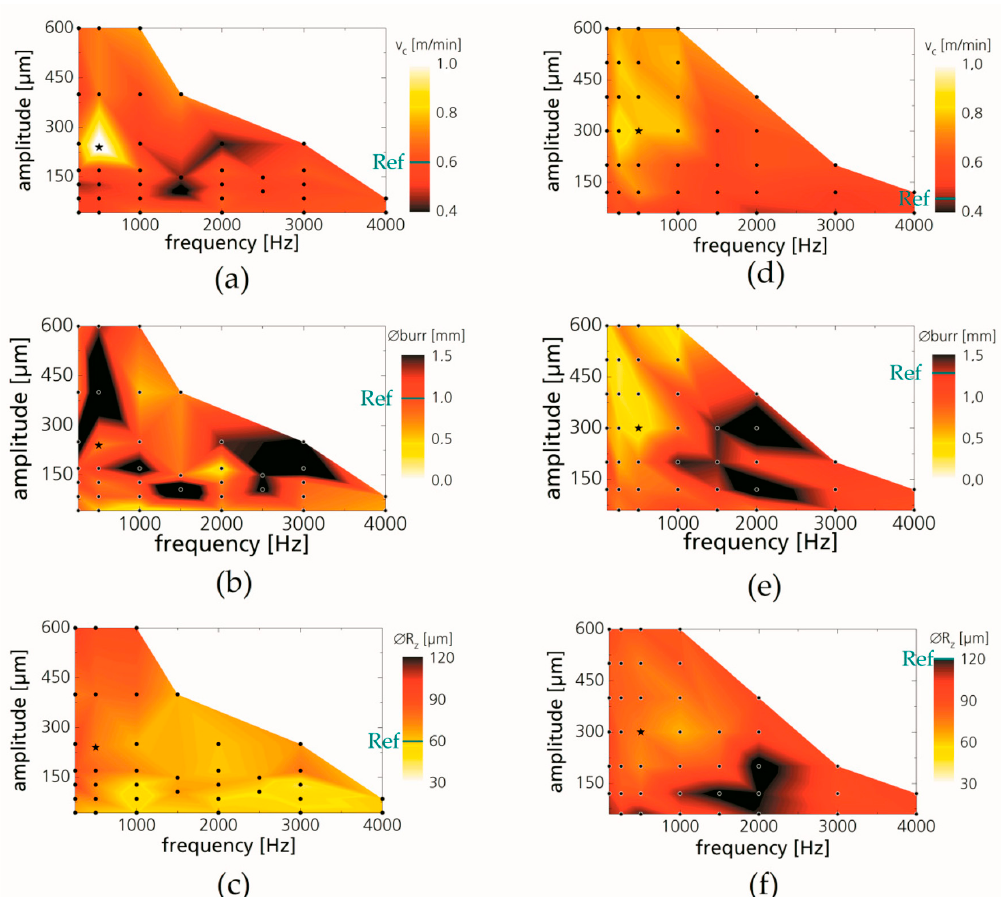
Figure 3. Contour plots of evaluated cutting results for cutting speed ( a , d ), burr height ( b , e ), and surface roughness ( c , f ) for 12 mm stainless steel ( a , b , c ) and 12 mm mild steel ( d , e , f ) as a function of frequency and amplitude using longitudinal, linear beam oscillation. The stars denote the best cutting result. The reference values (Ref) corresponds to the values obtained with static beam shaping.